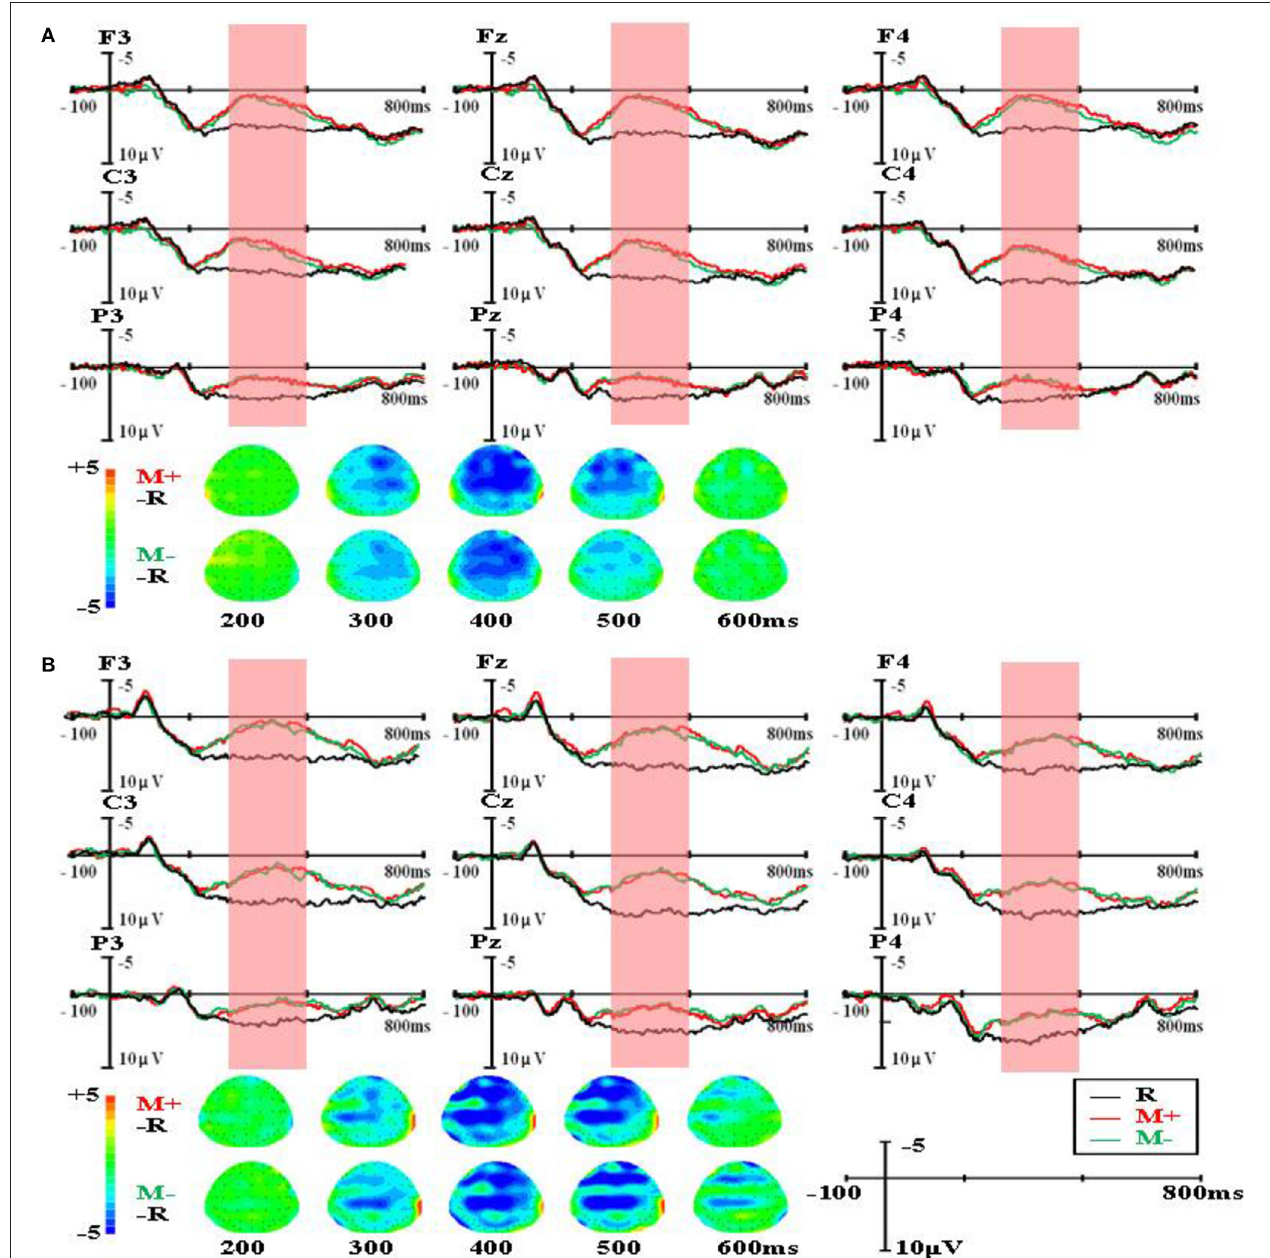
FIGURE 1 | The group-level average waveforms and scalp distribution elicited by different word types of the first presented sentences for higher proficiency (A) and lower proficiency participants (B) .